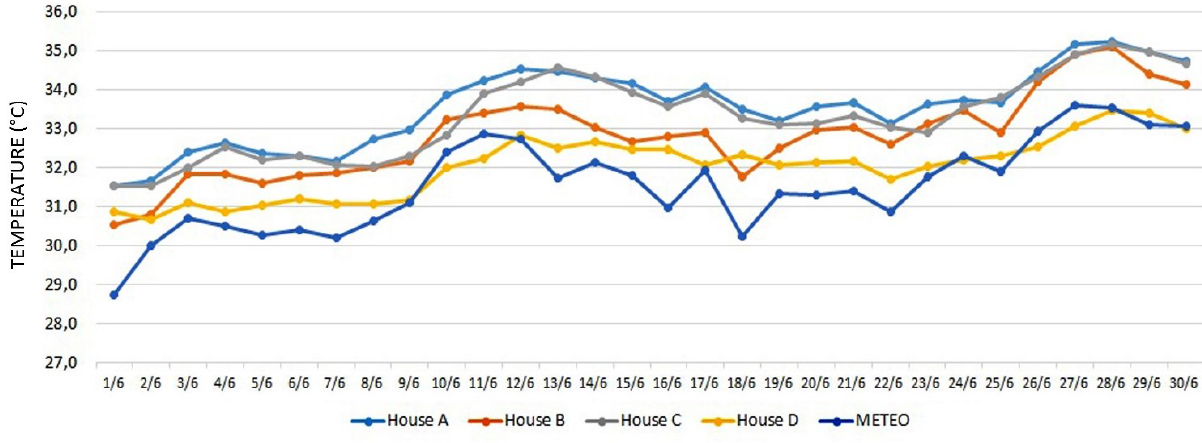
Figure 9. Graph of measuring the average air temperature at four stations compared to the temperature recorded by the Da Nang Meteorological Station in one month